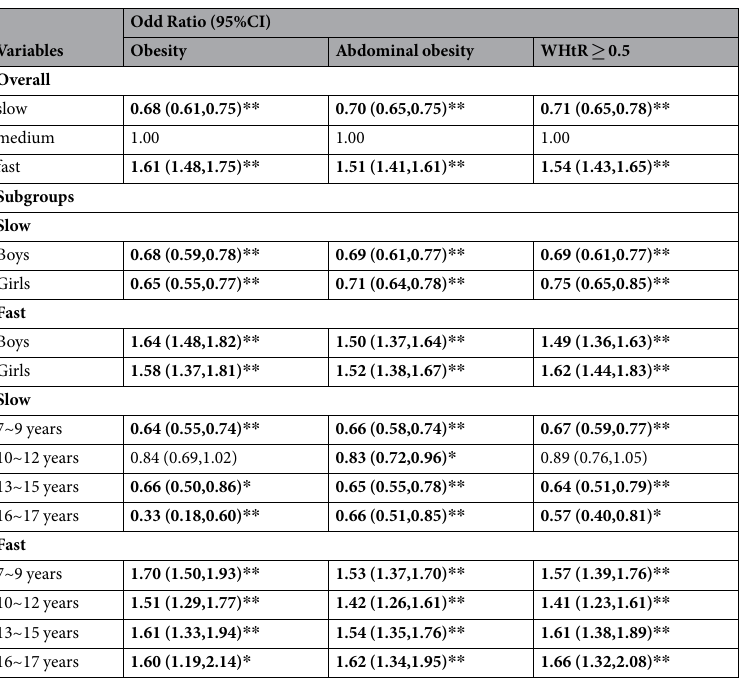
Table 3. Associations of eating speed with obesity and abdominal obesity by gender and age. Values are presented as OR and 95%CI. ** P < 0.001, * P < 0.05. Multivariate logistic regression model was applied with adjustment for gender, age, area, physical activity, family history of obesity, paternal and maternal educational level and family monthly income (all variables stratified by sex were not adjusted for